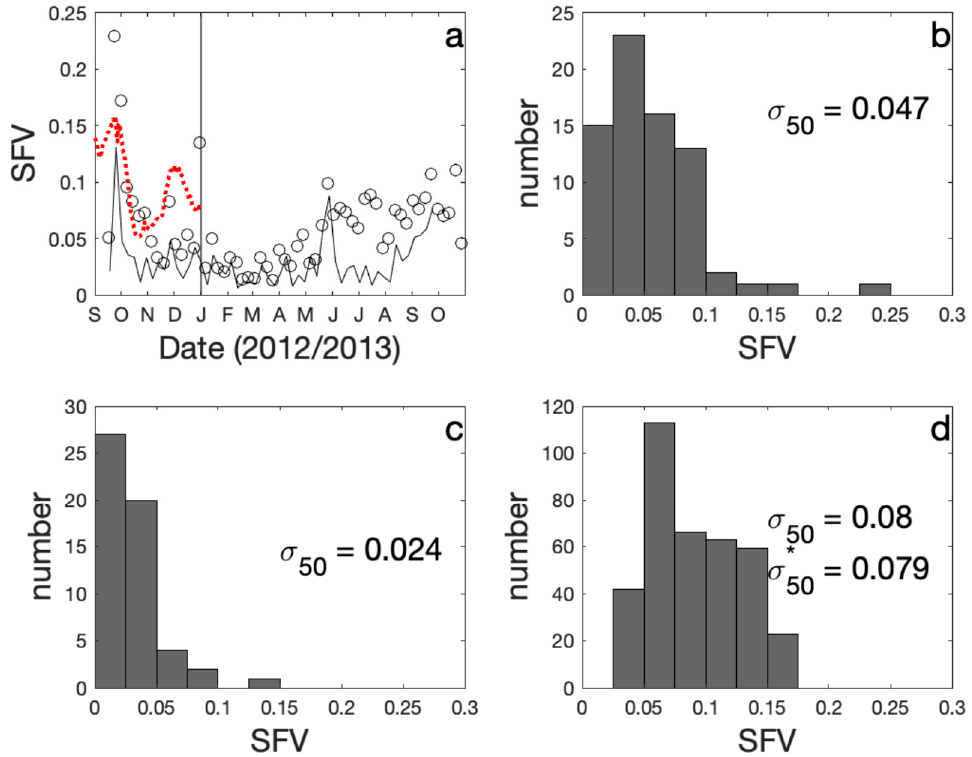
Figure 5. ( a ) Circles: Weekly SFV from the SPURS-1 in situ data. Light black line: Weekly standard deviation from the SPURS-1 central mooring. Red dotted line: Daily full SFV from the ROMS simulation. ( b ) Histogram of weekly SFV (circles in panel a). σ 50 is the median value. ( c ) As in panel b, but for the mooring (light black line in panel a). ( d ) As in panel b, but for the full ROMS simulation (red dotted line in panel a). σ 50 * is the median value of the SFV from the ROMS simulation sampled at the same times and locations as the in situ data. Note, less than half of the ROMS simulation SFV time series is displayed in panel a.